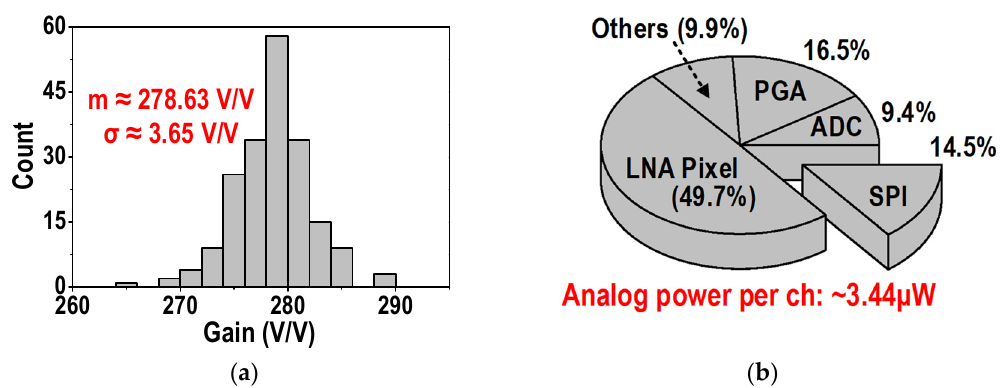
Figure 14. Measured characteristics of 10-b SAR ADC: ( a ) Input frequency from 10 Hz to 249 kHz versus signal to noise and distortion ratio (SNDR) and spurious free dynamic range (SFDR); ( b ) 32,768 points fast Fourier transform (FFT) with a full scale 5 kHz sinewave input.